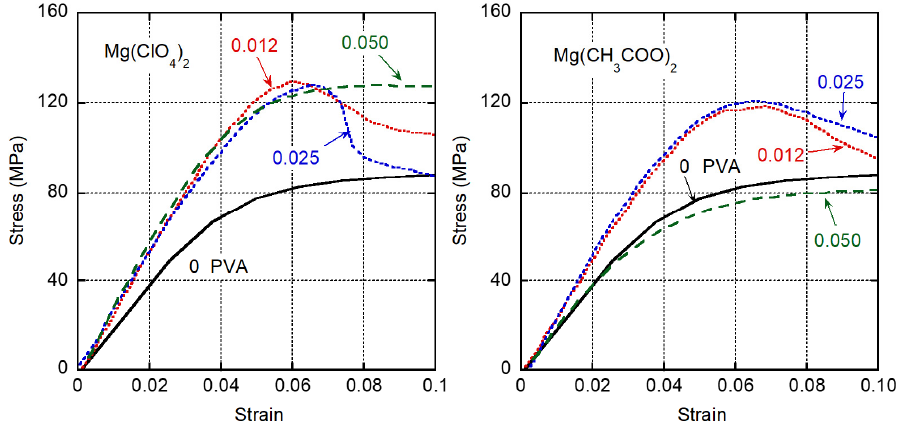
Figure 6. Stress–strain curves of films containing Mg(ClO 4 ) 2 ( left ) and Mg(CH 3 COO) 2 ( right ) at 23 °C. The numerals in the figure represent the molar ratios of the salts. Table 1. Tensile properties of the films.